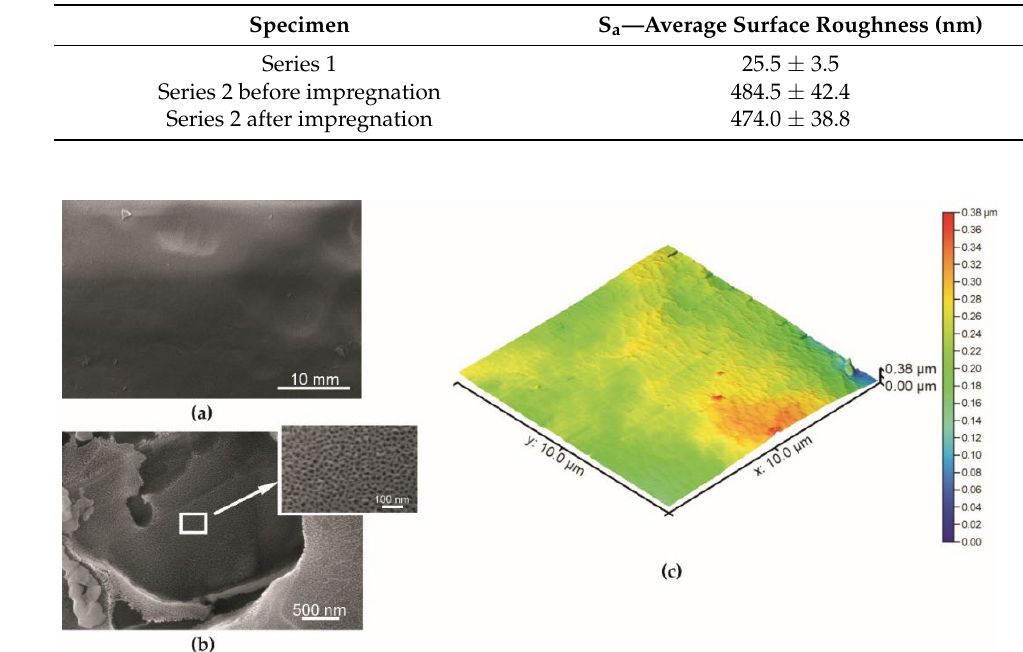
Figure 6. The surface of the specimen from Series 2 after impregnation by PDMS: ( a ) mag. 10,000×; ( b ) mag. 100,000×; ( c ) AFM topography. The nanoporous structure of the oxide layer with sharp edges formed on the uneven tops of the surface with a dimension from 2 µm to 10 µm on a specimen after abrasive blasting was observed. The V-shaped cavities occur between uneven tops of the structure (Figure 5a,b). In the case of a specimen with PDMS, nanoporous structures on the uneven structure with cracks are also observed (Figure 6a,b). However, the connection of na- nopores of anodized aluminum oxide with PDMS causes a change in surface image. Fur- thermore, the polymer fibers are observed in the layer cavities of the specimen with PDMS (red arrows, Figure 6b). SEM and AFM techniques (Figures 4–6) confirm a higher roughness of specimens from Series 2. The average roughness of specimens from Series 2 before and after impreg- nation is similar (Table 1). Profiles obtained from AFM topographies indicate that the coat- ing unevenness of specimens from Series 1 does not exceed a height of 60 nm. In the case of specimens from Series 2 before and after impregnation, the unevenness of the coatings oscillates in a range of about 2 µm (Figure 7).